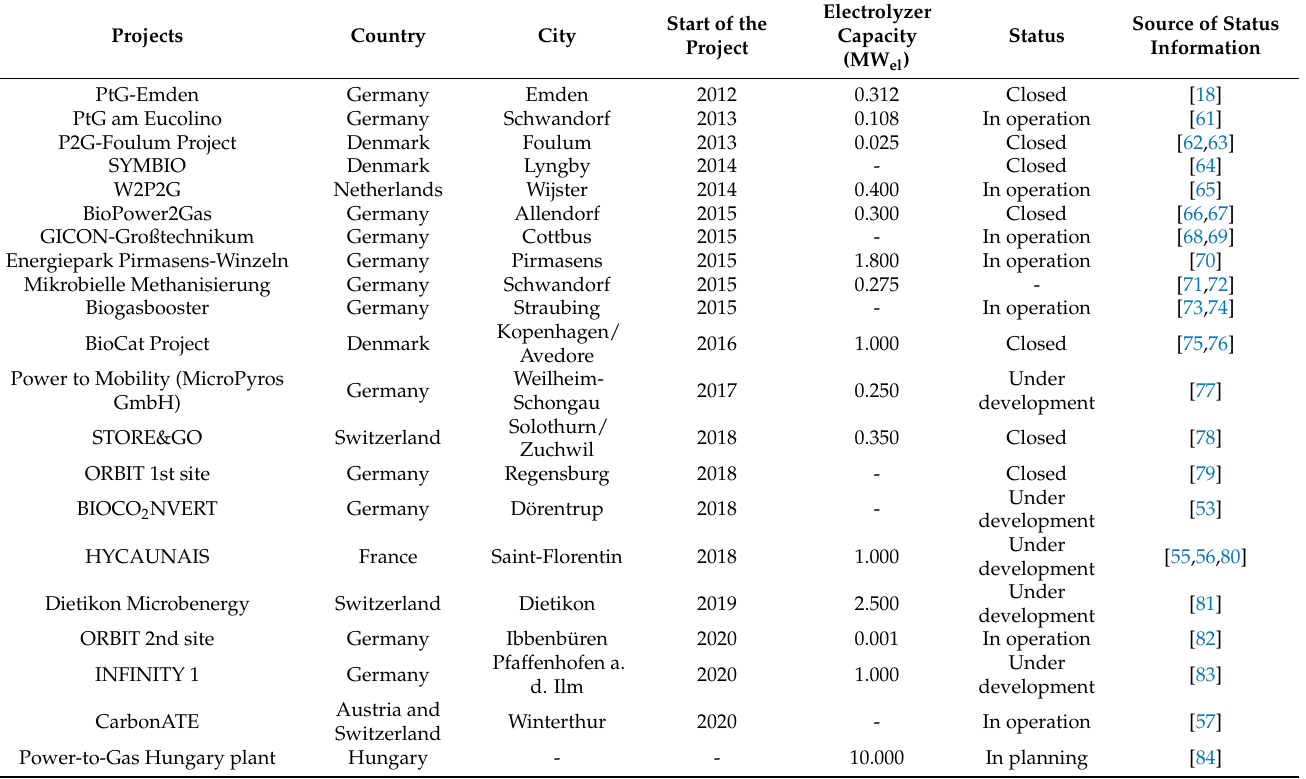
Table 2. European biomethanation projects with sufficient accessible information about capacity or status, based on [18,19] and own